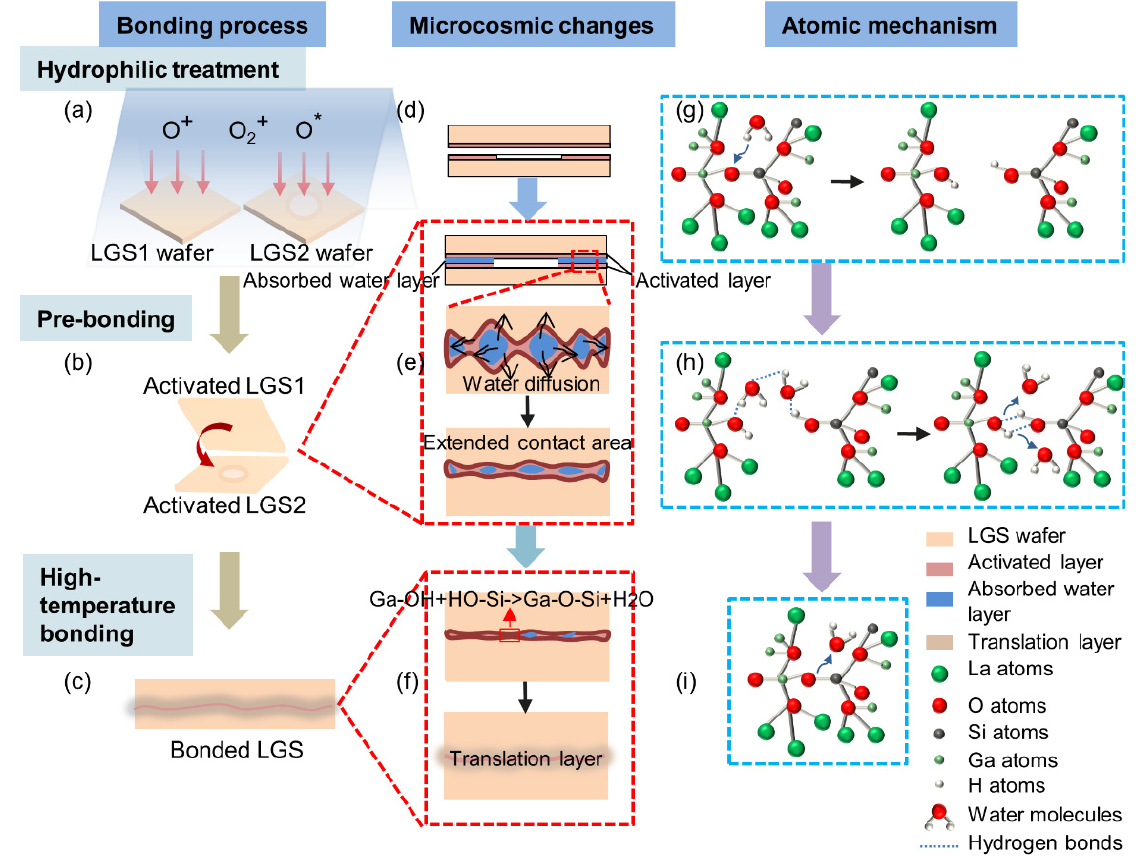
Figure 5. Schematic diagram of the mechanism for high ‐ temperature direct bonding of LGS via O 2 plasma activation: ( a – c ) bonding process; ( d – f ) microcosmic changes of bonding interface; ( g – i ) atomic mechanism of bonding.